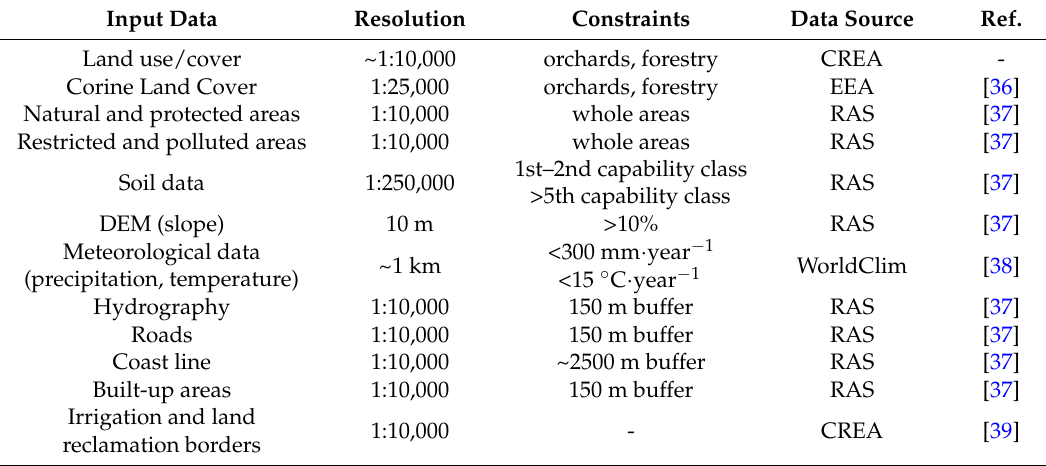
Table 2. Data sources used in the GIS-based suitability